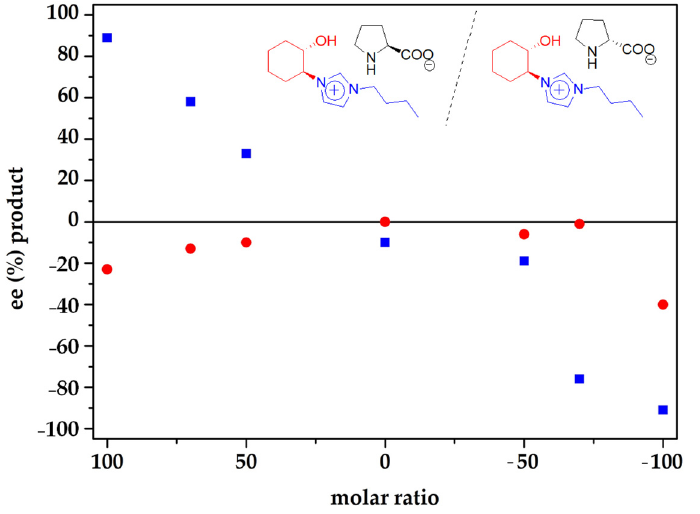
Figure 7. Influence of the configuration at the prolinate anion on the enantioselectivity observed for the anti (blue squares) and syn (red circles) pairs formed in the aldol reaction between p -nitrobenzaldehyde and cyclohexanone using different molar ratios of ( S , S )- trans -Cy6-OH-Im-Bu- L -Pro:( S , S )- trans -Cy6-OH-Im-Bu- D -Pro (40% molar loading) at room temperature under solventless conditions: 27 h, 1:10 aldehyde( 1 ):cyclohexanone ratio, constant concentration of catalyst (0.38 M).